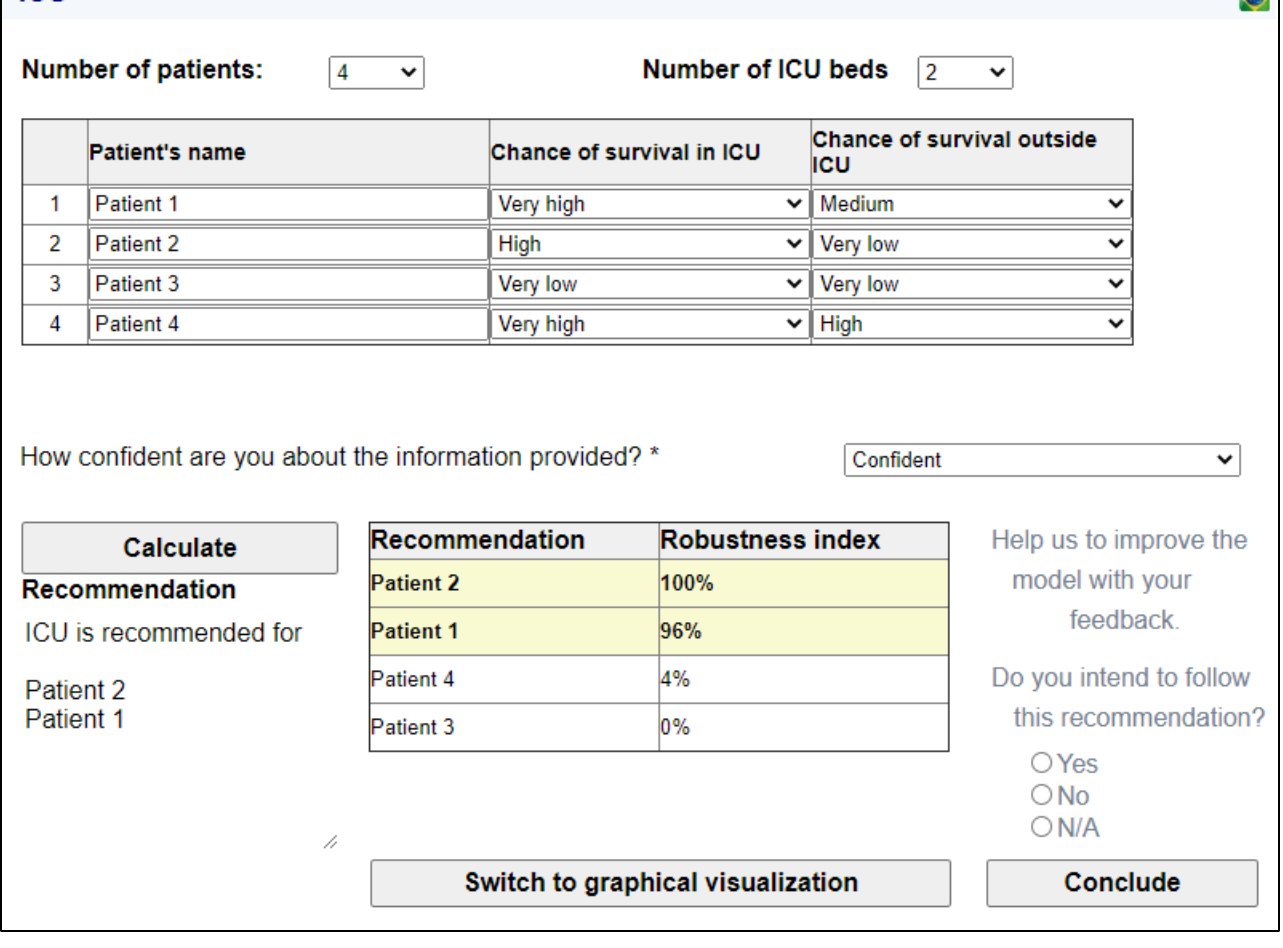
Figure 3. Results and recommendation (tabular visualization).